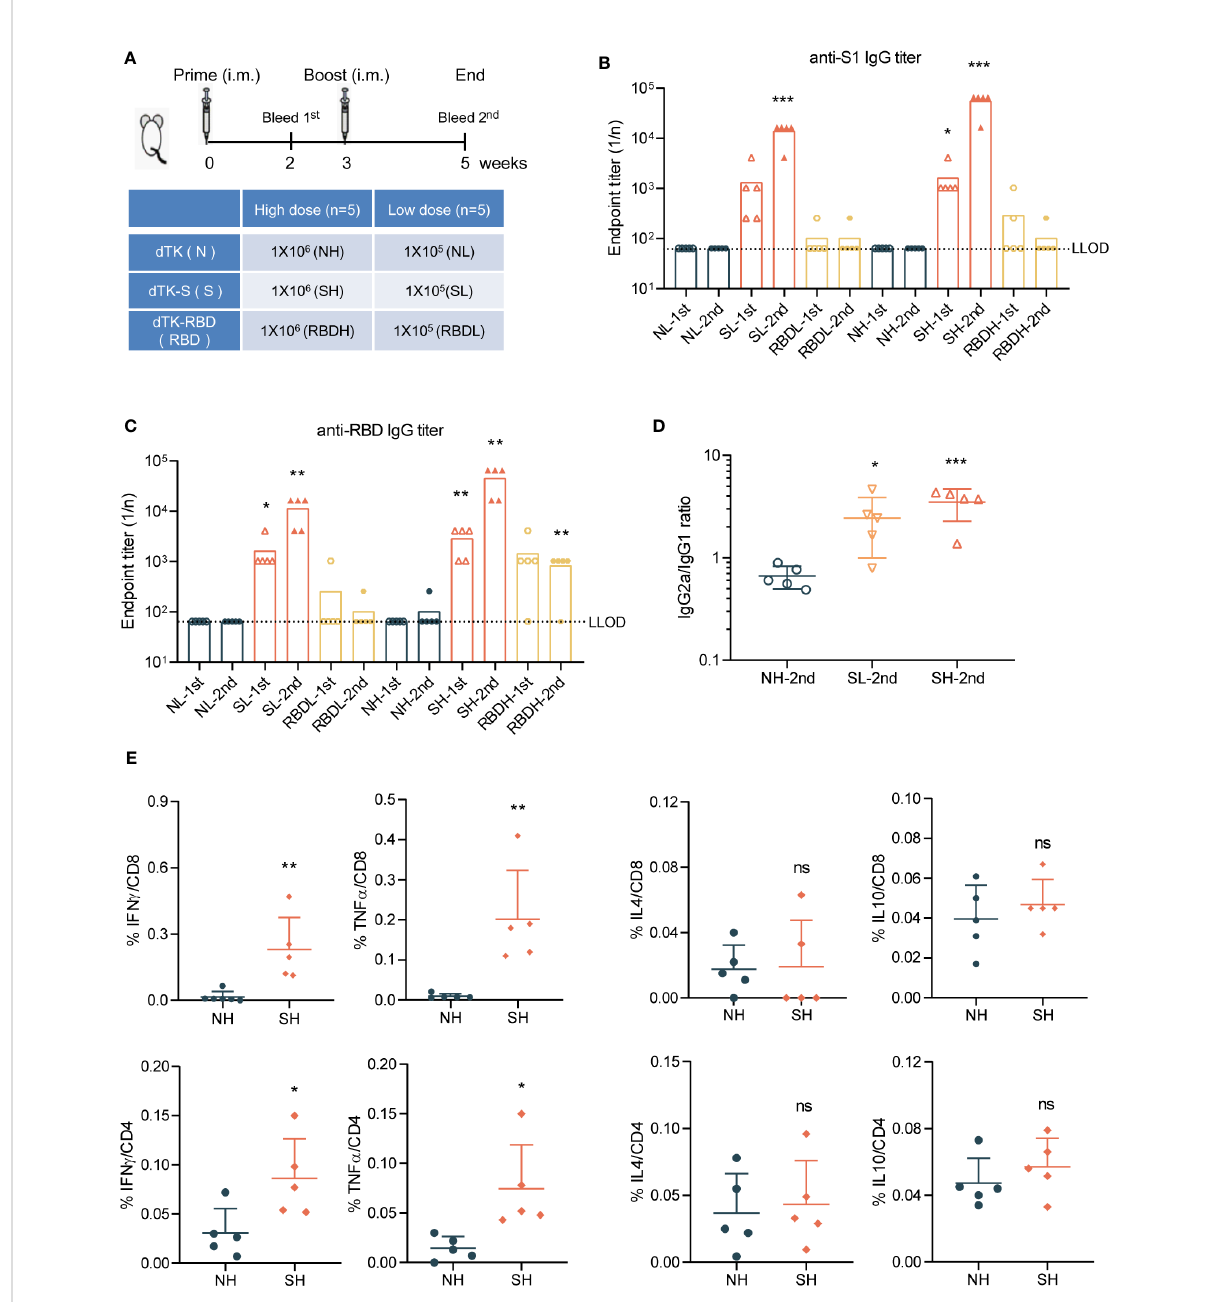
FIGURE 3 dTK-S VACV elicits effective humoral and cellular immunity in mice. (A) Immunization scheme. BALB/c mice aged 6 – 8 week were intramuscularly immunized with 1 × 10 5 or 1 × 10 6 PFU of control dTK, dTK-S, or dTK-RBD at week 0 and week 3. Sera were collected 2 weeks after each vaccination for further quanti fi cation of antibody responses. (B – D) Humoral responses in sera of immunized mice were evaluated. S1-binding antibody (B) and RBD-binding antibody (C) were analyzed by ELISA. The IgG2a/IgG1 ratio of S1-binding antibody in dTK-S immunized mice was detected by ELISA using HRP-conjugated isotype-speci fi c antibodies (D) . (E) T-cell response induced by dTK-S. CD8 and CD4 T cells expressing IFN g , TNF a , IL-4, and IL-10 in the spleen of dTK- or dTK-S-immunized mice (high dose) were evaluated by intracellular cytokine staining, after stimulation with S peptides. Dotted lines indicate the lower limit of detection (LLOD). Animals with a response at or below the LLOD were put on LLOD. Statistical differences as determined by Student ’ s t -tests are indicated by asterisks; * p < 0.05, ** p < 0.01; *** p < 0.001. 1st, sera collected 2 weeks after prime; 2nd, sera collected 2 weeks after boost; L, low dose (10 5 PFU); H, high dose (10 6 PFU); N, dTK immunization; S, dTK-S immunization; RBD, dTK-RBD immunization. dTK-S, vaccinia virus-expressing spike protein; VACV, vaccinia virus; PFU, plaque-forming unit; RBD, receptor-binding domain; HRP, horseradish